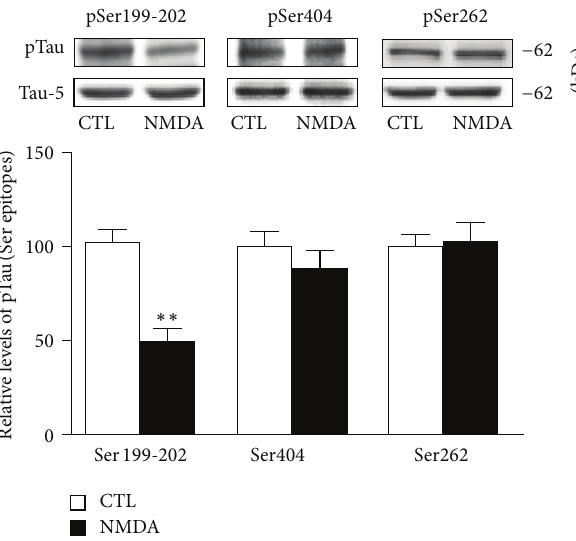
Figure 4: NMDA-induced changes in Tau phosphorylation are NR2A receptor-dependent. Phosphorylated Tau levels at Ser199- 202 were estimated by Western blotting of cell extracts obtained from hippocampal slices. In basal conditions, slices were exposed to an NMDA concentration (1 𝜇 M) which had no effect on Tau phosphorylation. In parallel experiments, NMDA-treated slices were preincubated with the NR2B receptor antagonist RO25-6981 (1 𝜇 M), the NR2A receptor antagonist NVP-AAM077 (50 nM), or with a mixture of NR2B and NR2A (RO25-6981; 1 𝜇 M and NVP-AAM077; 50nM) receptor antagonists. Representative West- ern blots and quantitative data on each condition revealed that NMDA-induced reduction of Tau phosphorylation was exacerbated after blockade of NR2B receptors. On the contrary, Tau becomes hyperphosphorylated after blockade of NR2A receptors with NVP- AAM077 (50nM). The data, expressed relative to total Tau (i.e., Tau- 5) levels, are means ± S.E.M. of 3 measurements per cell extract obtained from 8 different rats. For statistical analysis, one-way ANOVA was followed by Newman-Keuls post hoc test. ∗ 𝑃 < 0.05 , ∗∗ 𝑃 < 0.01 , drug-treated versus